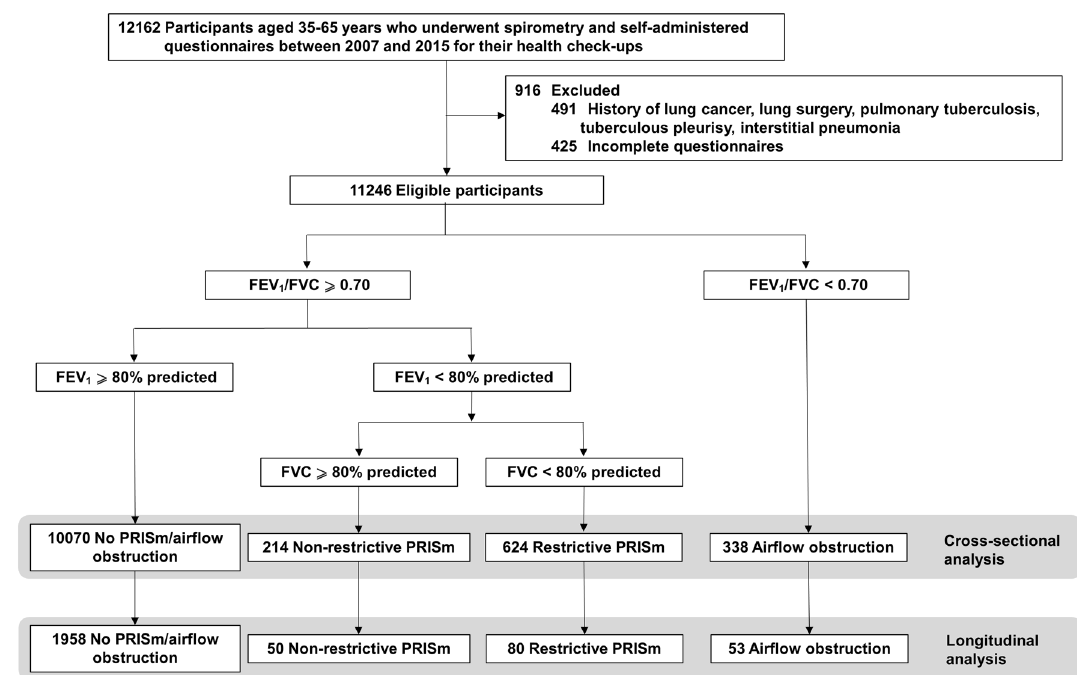
Figure 1. Flow diagram of the participant selection process in this study. FEV 1 —forced expiratory volume in 1 s; FVC—forced vital capacity; PRISm—preserved ratio impaired